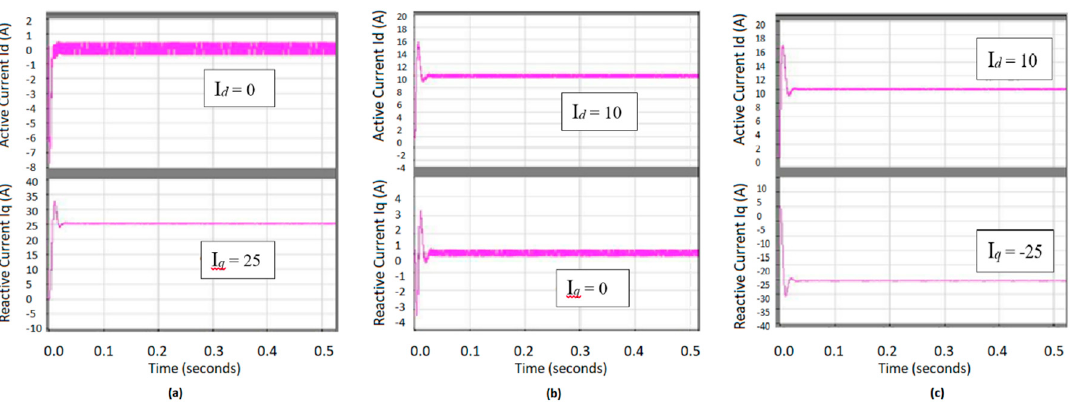
Figure 21. ( a ) The dq components of the injected RP for the loading scenario (L1); ( b ) the dq components of the transferred current in the transmission lines for L1; ( c ) the dq components of the distributed current for L1.